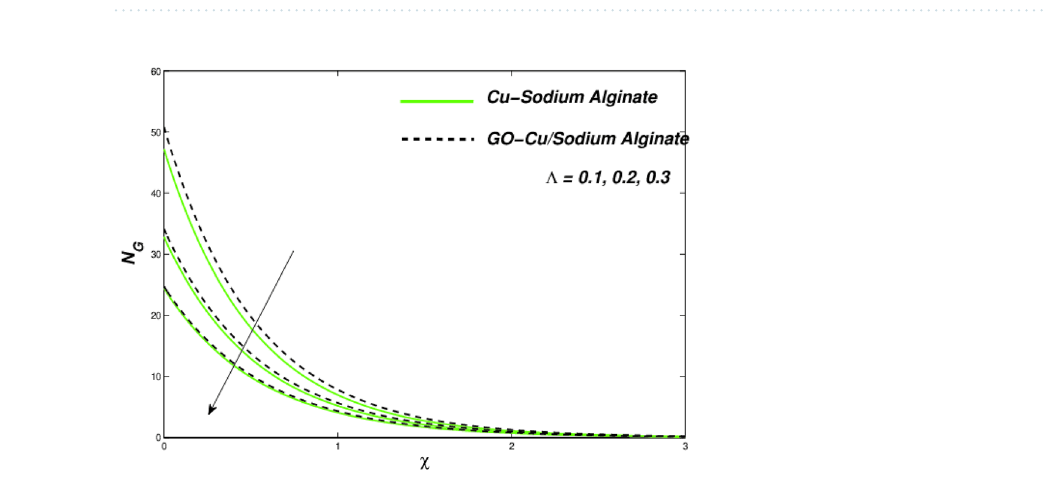
Figure 19. Temperature variations subject to (cid:31) .